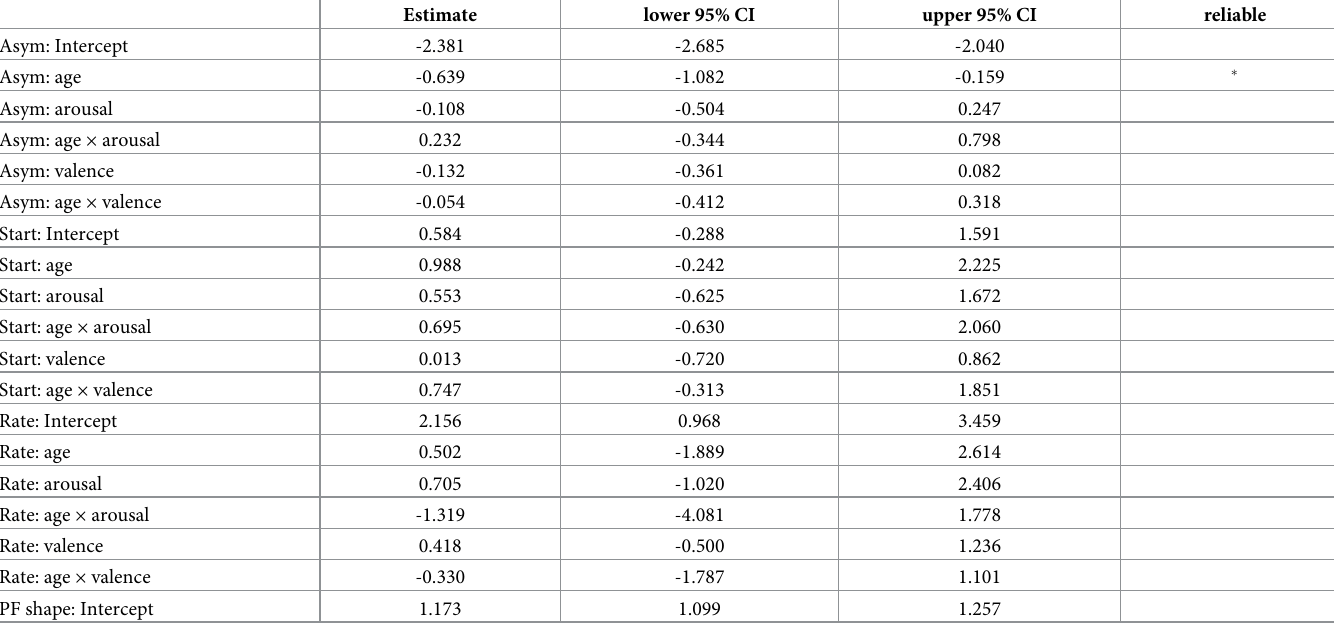
Table 2. Coefficients and CI from the full mixed-effects model of exponential